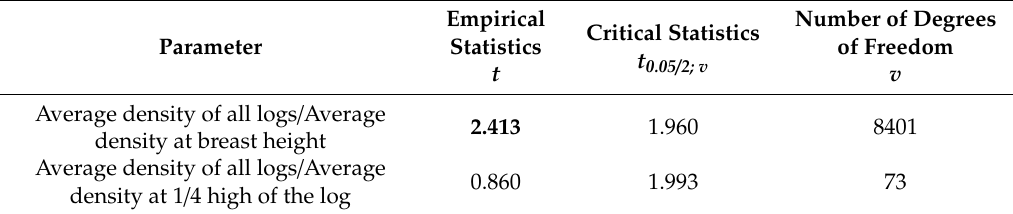
Empirical Number of Degrees Critical Statistics Statistics of Freedom t 0.05 / 2; v t v 2.413 1.960 8401 0.860 1.993